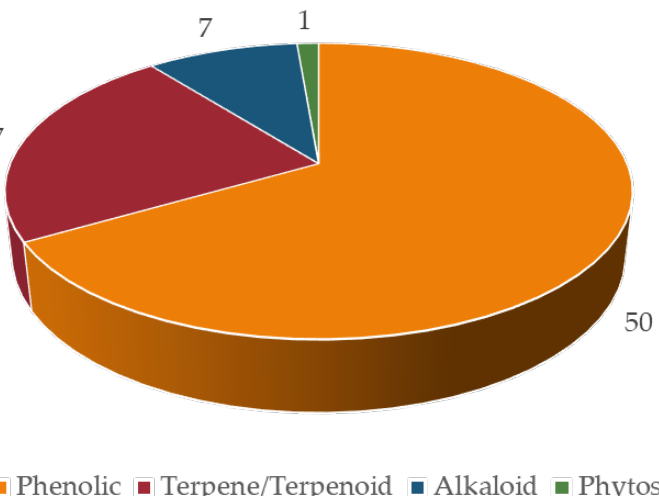
Figure 9. Number of bioactives inducing/inhibiting at least four targets, according to chemical class. Amongst the 50 phenolic compounds listed in Table 4, apigenin, EGCG, genistein, hy- pericin, quercetin, caffeic acid, catechin, cinnamaldehyde, curcumin, delphinidin,